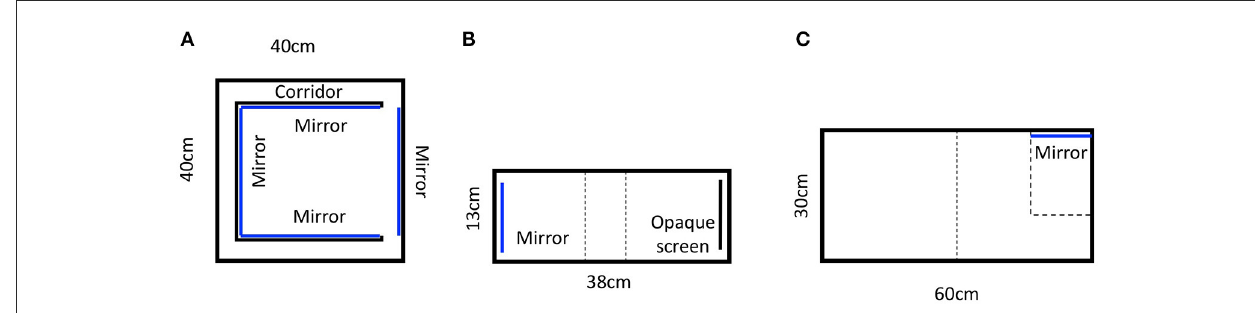
FIGURE1 Apparatus of mirror experiments. (A) Toubas et al. (1990), (B) Watanabe (2016), (C) Ueno et al. (2020). Blue lines represent